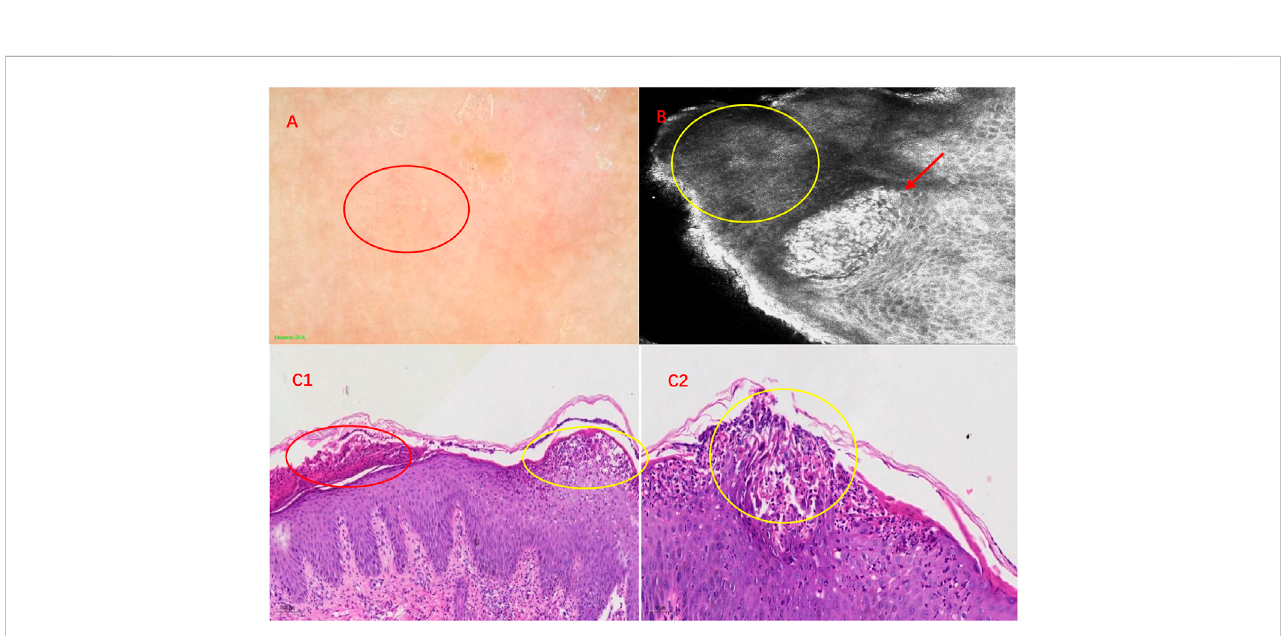
FIGURE 2 Imaging and histopathological features of IPP. (A) Features of IPP under dermoscopy. Under a reddish background, multiple punctate, annular, and hairpin-likevessels areshown byared circle. (B) RCM showedneutrophilin fi ltrationsamongkeratinocytes inthestratum spinosum, which wascalledKogoj ’ s spongiform pustules (red arrow). The yellow circle displays dyskeratotic cells. (C1) Hyperkeratosis, parakeratosis (red circle), acanthosis, formation of subcorneal pustules (Kogoj ’ s spongiform) (yellow circle), and hemangiectasis with neutrophilic and lymphocyte in fi ltration in the papillary dermis (HE, ×100). (C2) Subcorneal pustules (Kogoj ’ s spongiform) distributed among acanthocytes (yellow circle) (HE, ×